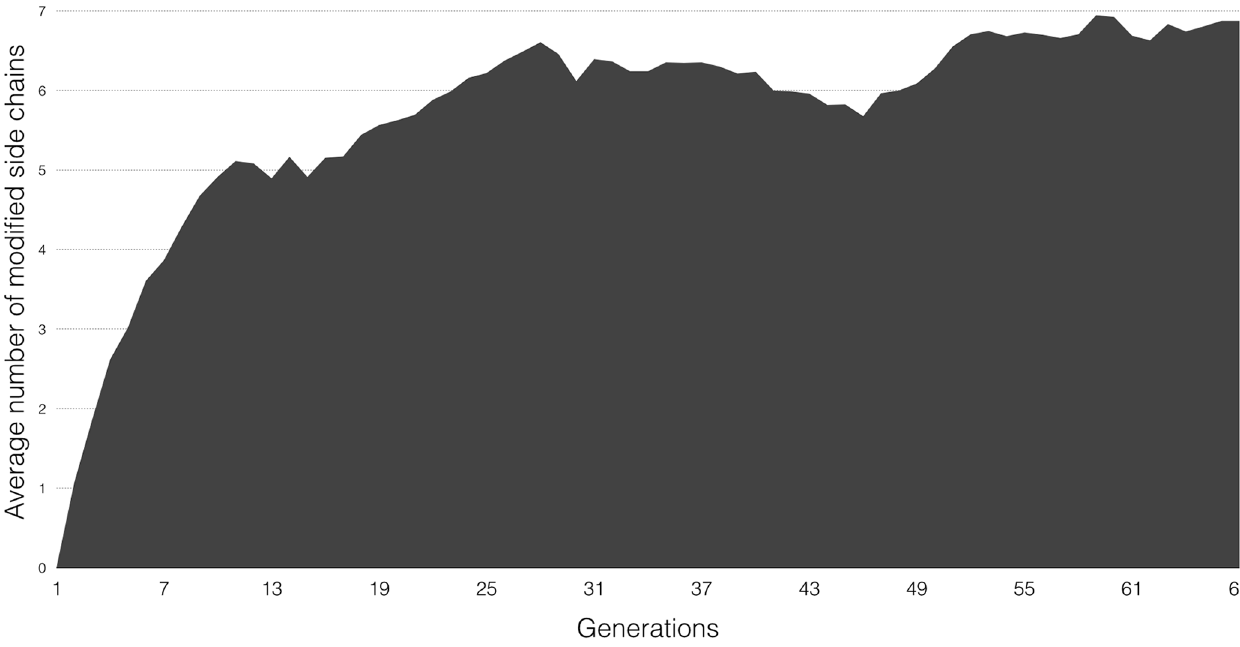
Fig 7. Frequency of receptor side-chain changes in the GA population during a successful docking of the 4EK6 ligand docked into the corresponding 4EK3 apo receptor with 12 flexible side-chains. The figure plots the evolution of the average number of receptor side-chains with a modified conformation over successive generations of the GA optimization. In the initial population all receptor side-chains are in the apo conformation. The number of side-chains changing rotameric state in individuals of the optimized population quickly increases in the first few generations and reaches a plateau. This profile is typical and observed in all runs for all